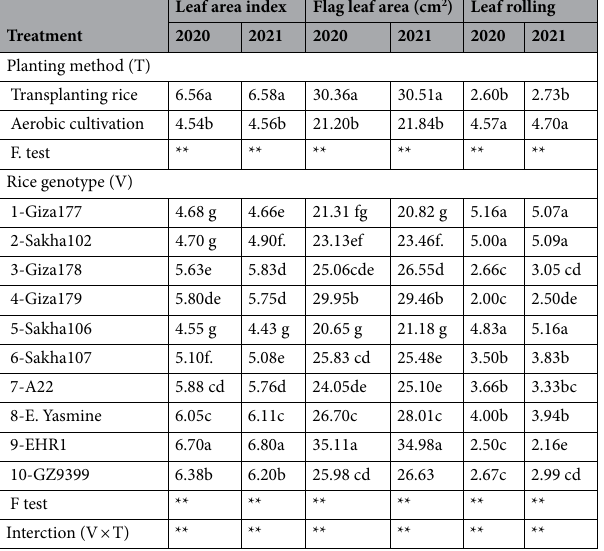
Table 4. Growth parameters of some rice genotypes affected by the planting methods. Means followed by a common letter at the same column are not significantly different according to Duncan ’ s multiple range at 0.05 levels. *Significant at 0.05 level. **Significant at 0.01 level.